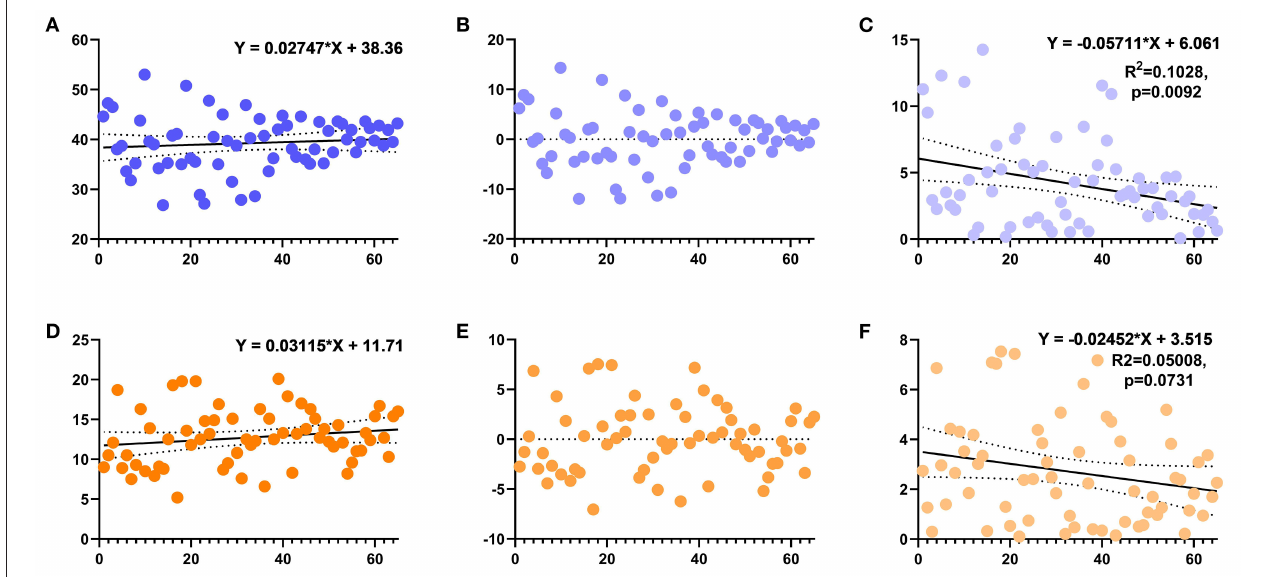
FIGURE 6 | Scatter plot showing the anteversion and inclination angles of the acetabulum in the DAA group. (A) The inclination angle of the acetabulum changes with the learning curve and its linear regression equation (non-significant). (B) The residual deviation of inclination from the target. (C) The absolute value of the residual deviation of the acetabular inclination angle and its linear regression. (D) The anteversion angle of the acetabulum changes with the learning curve and its linear regression equation (non-significant). (E) The residual deviation of anteversion from the target. (F) The absolute value of the residual deviation of the acetabular anteversion and its linear regression.